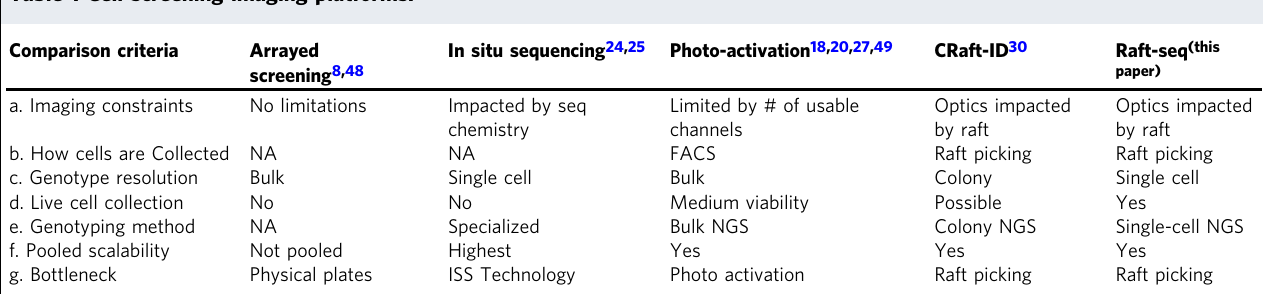
Table 1 Cell screening-imaging platforms. Comparison